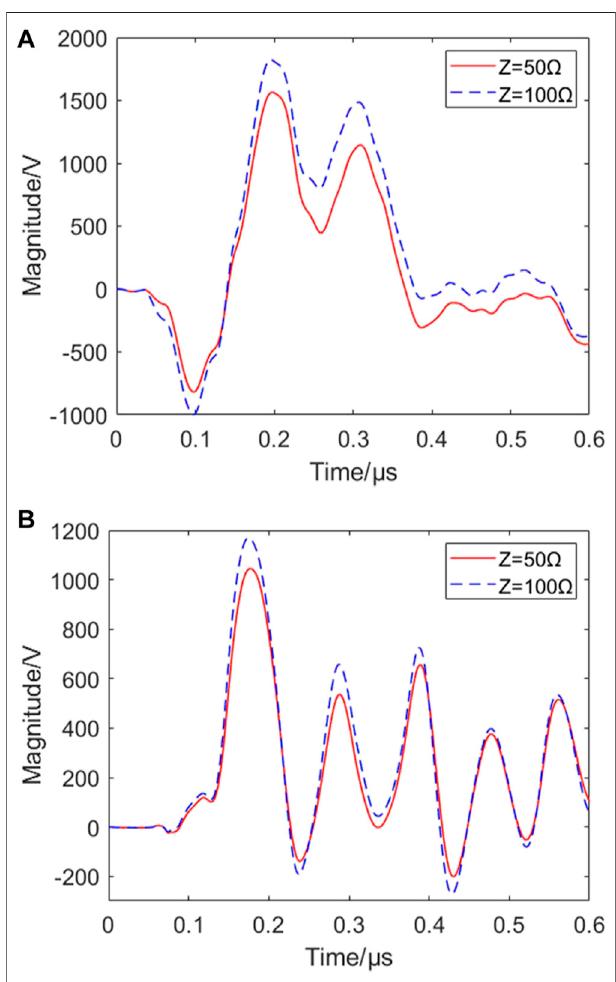
FIGURE 13 | Conducted disturbance voltage of secondary cable at different terminal impedance. (A) Capacitive conducted disturbance. (B) Resistive conducted